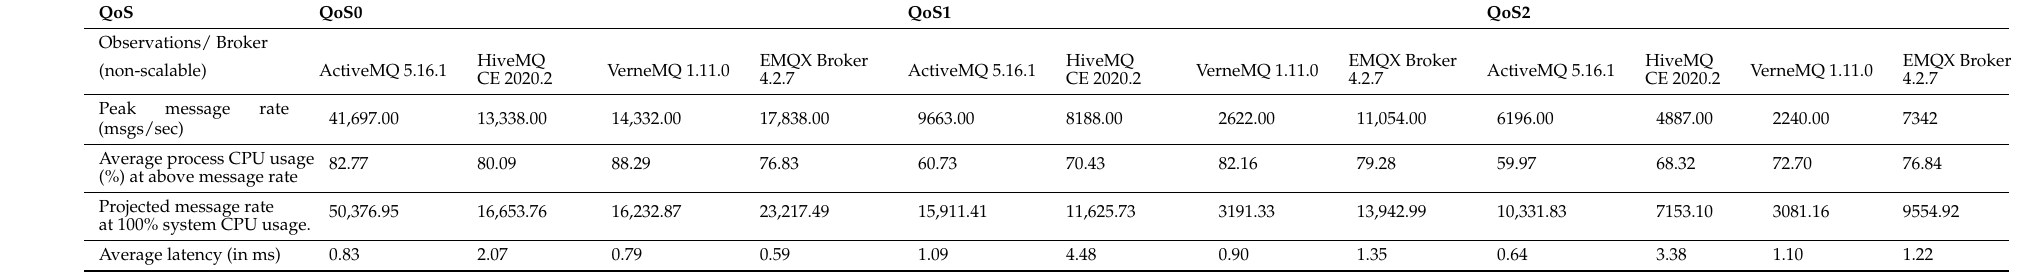
Table 9. Projected message processing rates of scalable brokers at 100% system CPU usage ( cloud test results). All the brokers listed in this table are scalable in nature and can use all cores available in the